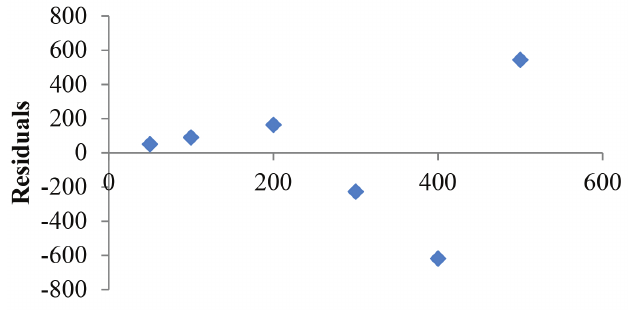
FIGURE 4 - Residual analysis of calibration curve.